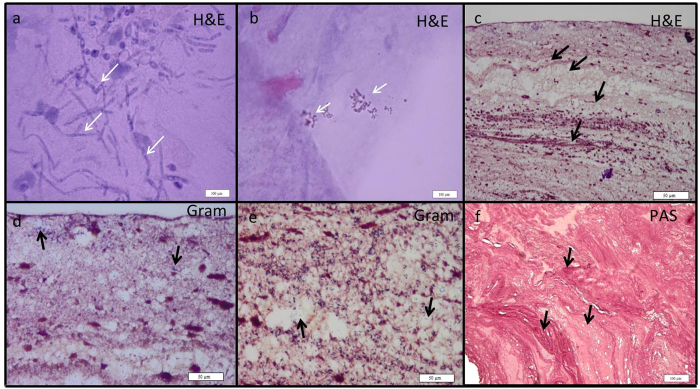
Histology of typical ETT biofilms.H&E staining revealed the presence of candida hyphae, white arrows (a); bacterial clusters, white arrows (b); and a clearly layered structure, black arrows (c); lacunae that harbored human cells are shown in the Gram-stained slices (d and e, black arrows); PAS stain also showed the layered structure (black arrows) and many cavities (f).